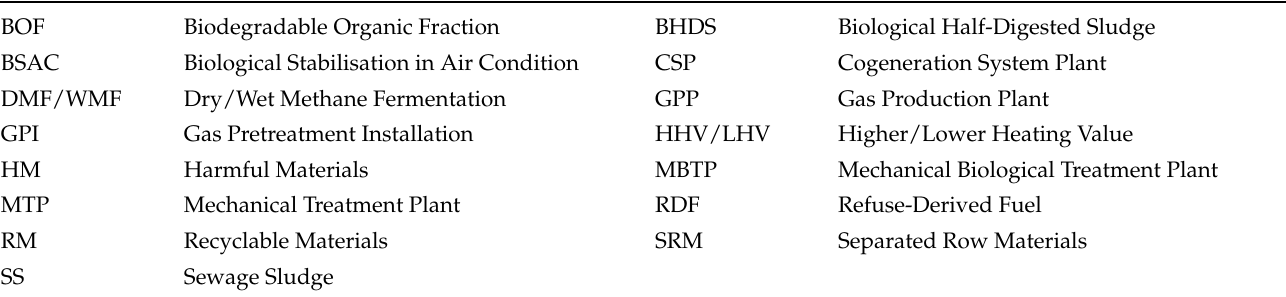
Table 2. List of